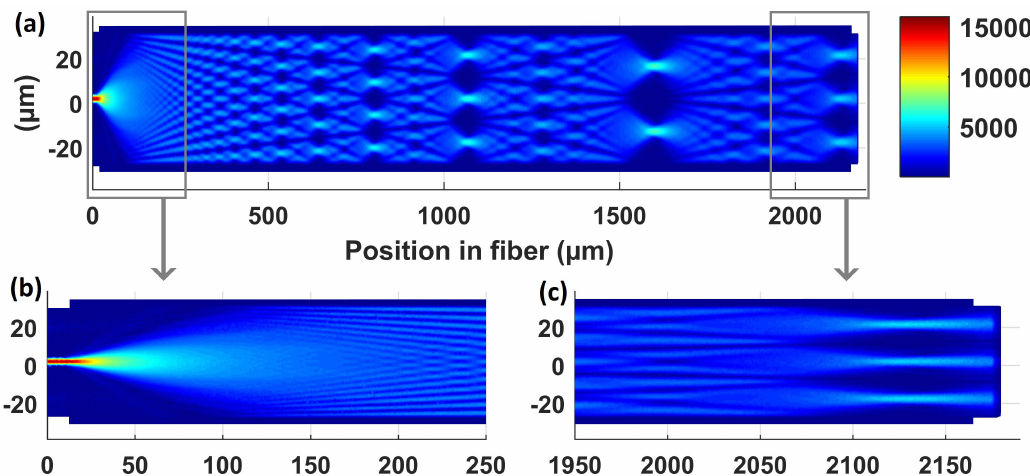
Figure 2. A COMSOL multiphysics simulation of an inline interferometer at the wavelength 1550 nm and an external RI 1.33. Inset ( a ) shows the whole simulated structure, whereas the insets ( b , c ) show the input and output part of the thin core fiber (TCF) respectively.